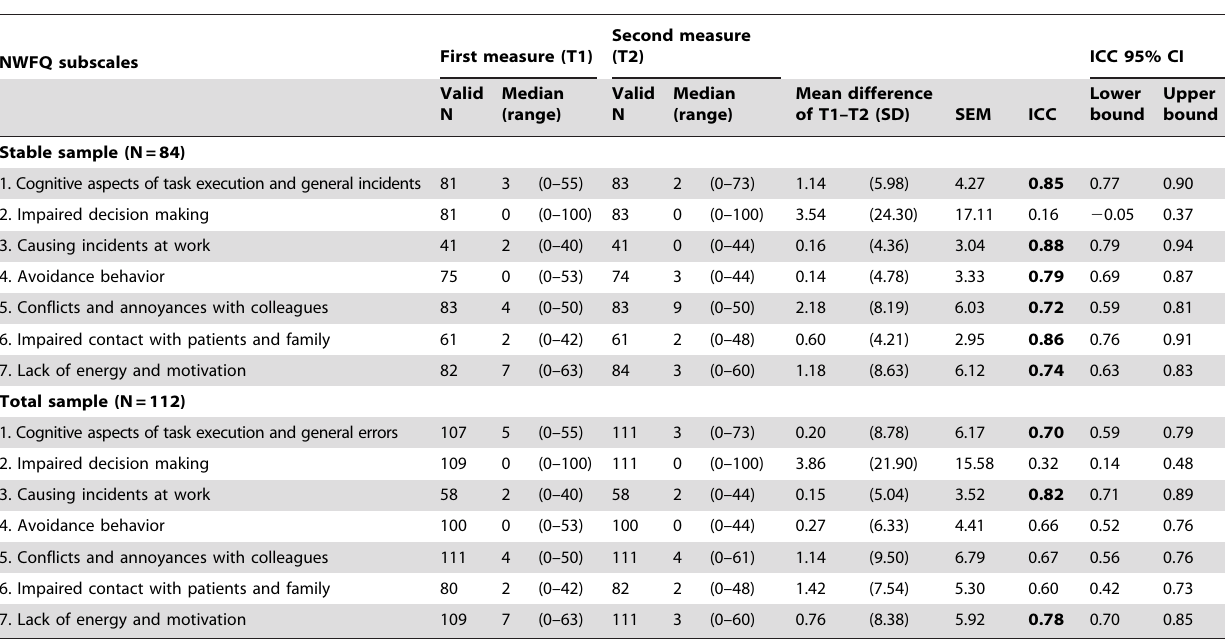
Table 2. ICC and SE of the sample who completed both questionnaires at T1 and T2.